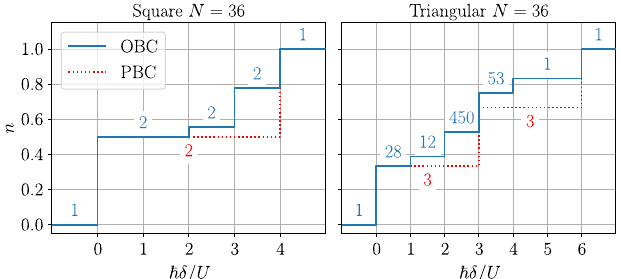
FIG. 7. Classical ( Ω ¼ 0 ) phase diagrams for arrays with open boundary conditions, with Rydberg density n as a function of x ¼ ℏ δ =U for the N ¼ 36 square and triangular arrays used in the experiment. Blue lines correspond to open boundary conditions, while red dashed lines correspond to periodic boundary con- ditions (bulk phase diagram). The numbers indicate the degen- eracy of the classical configurations for the distinct